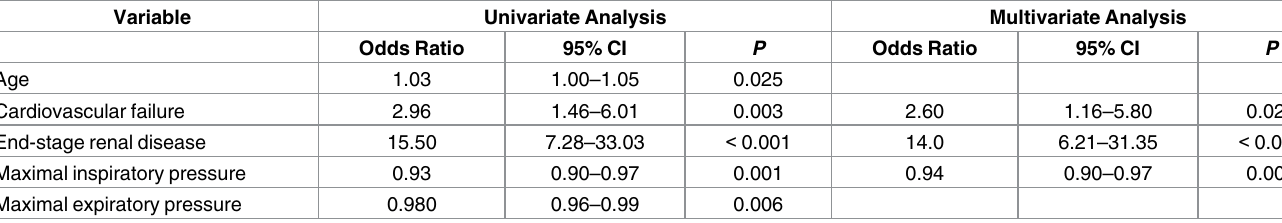
Table 4. The predictors of failed planned-extubation within 48